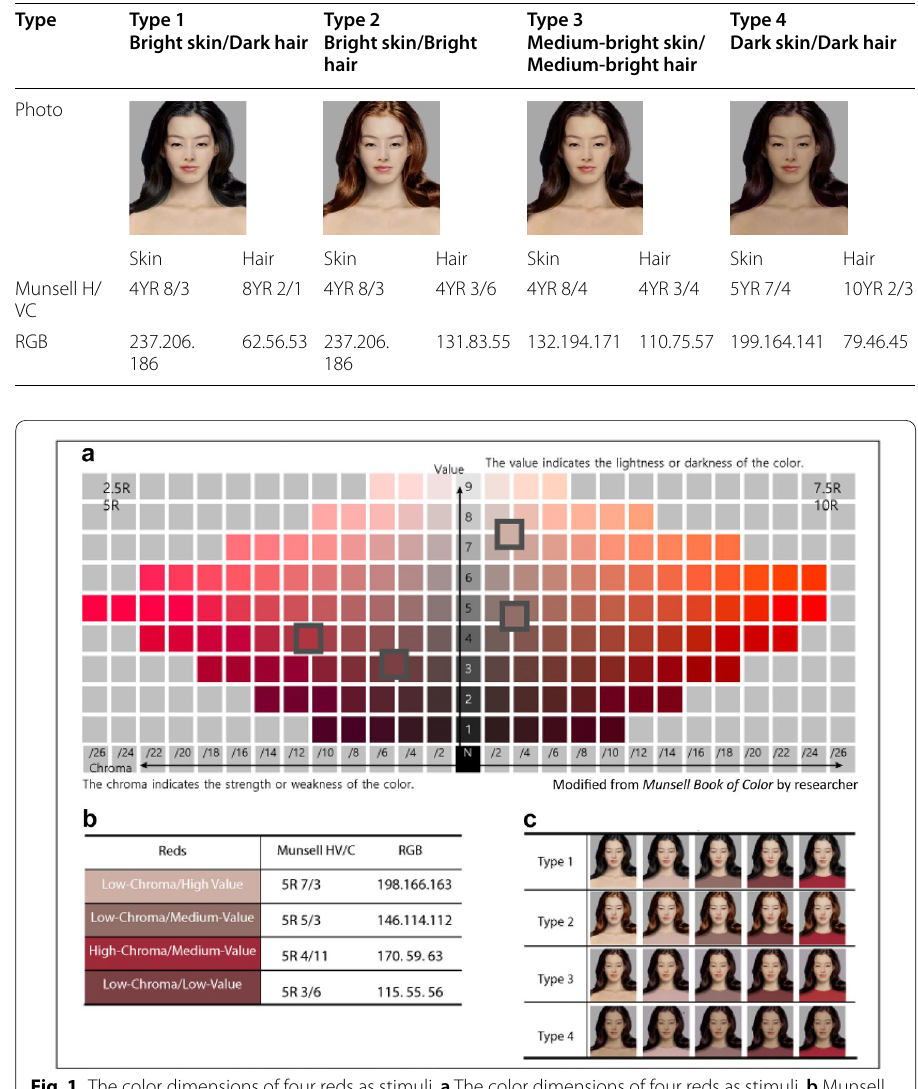
Fig. 1 The color dimensions of four reds as stimuli. a The color dimensions of four reds as stimuli. b Munsell color codes with RGB of four reds. c The combinations of the photo